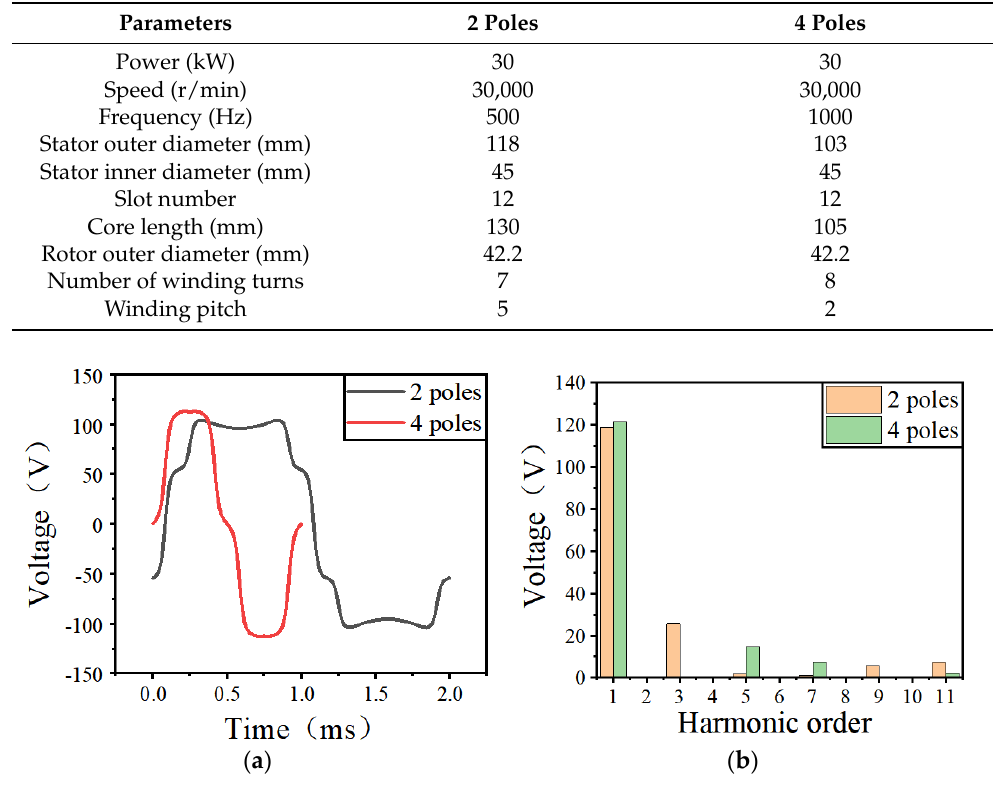
Figure 1. Waveforms and FFT analysis results of back EMF for 2 poles and 4 poles HSPMMs. ( a ) Waveforms; ( b ) FFT analysis results.